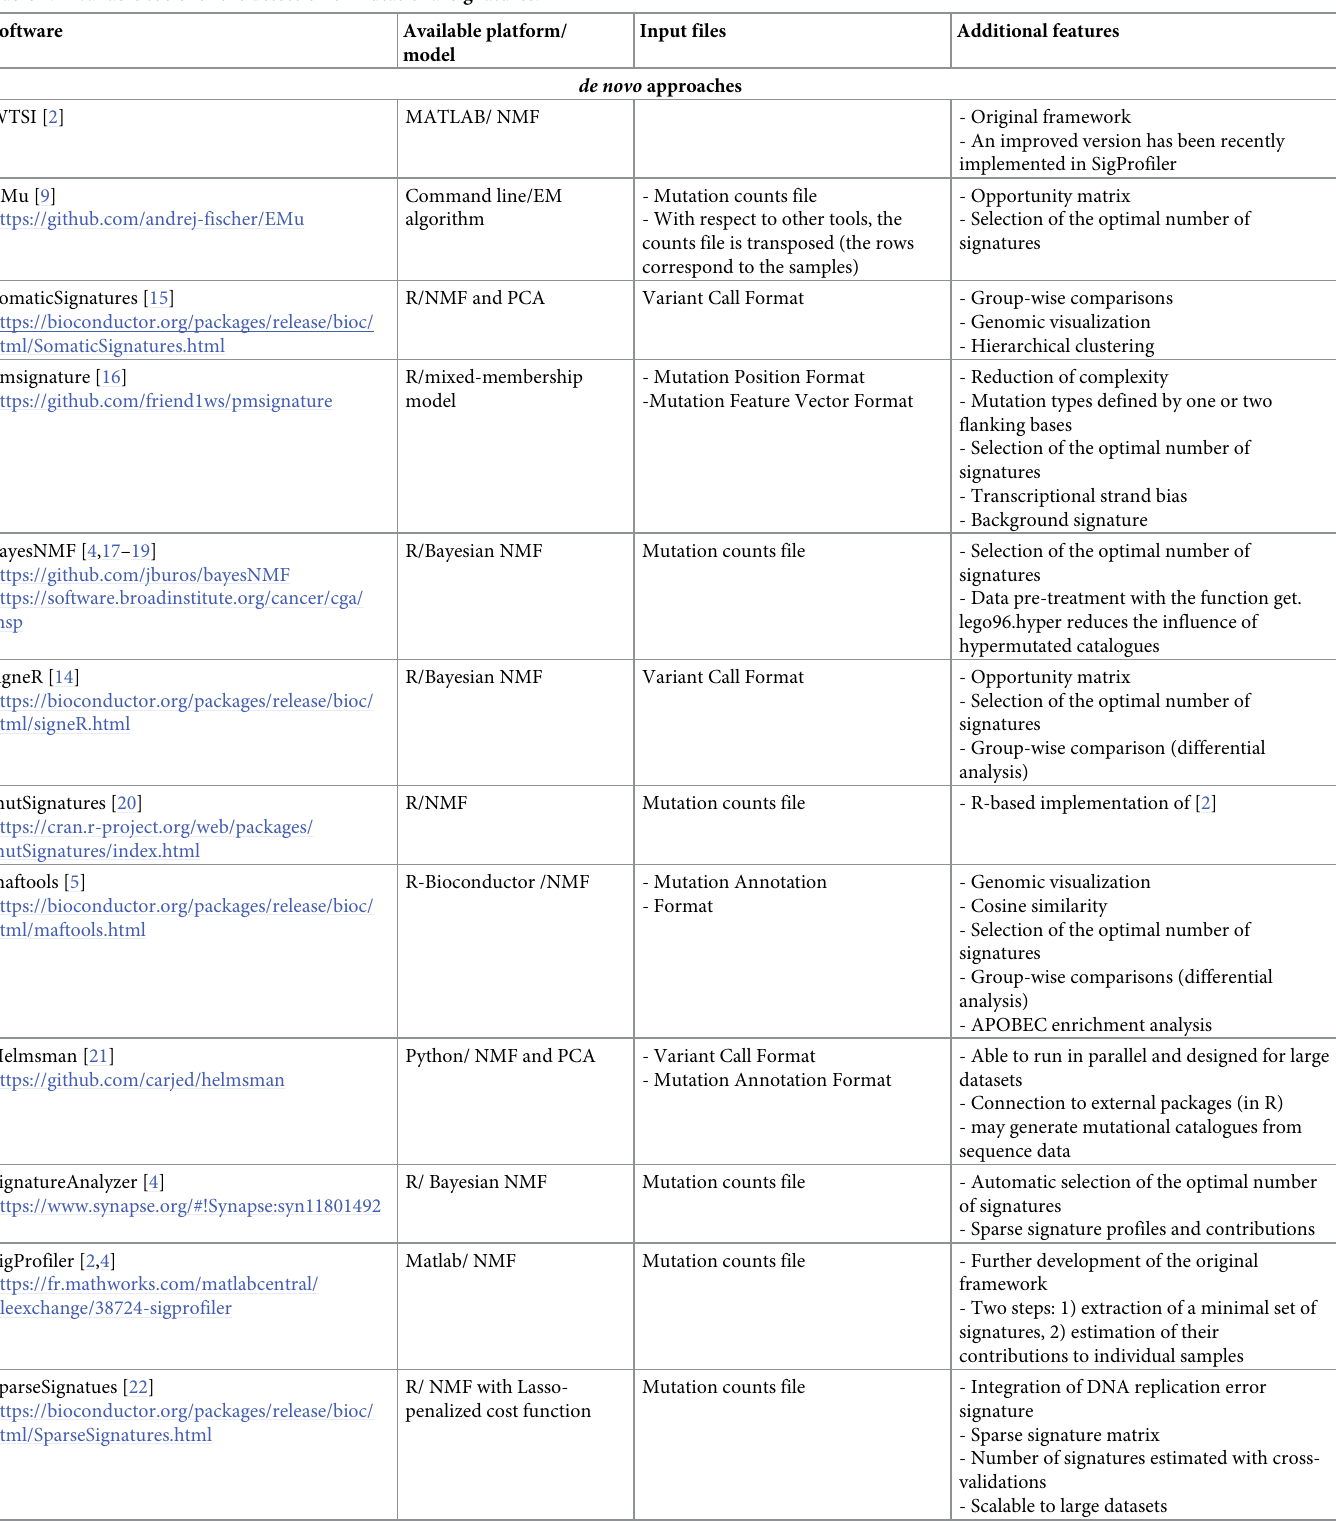
Table 1. Available tools for the detection of mutational